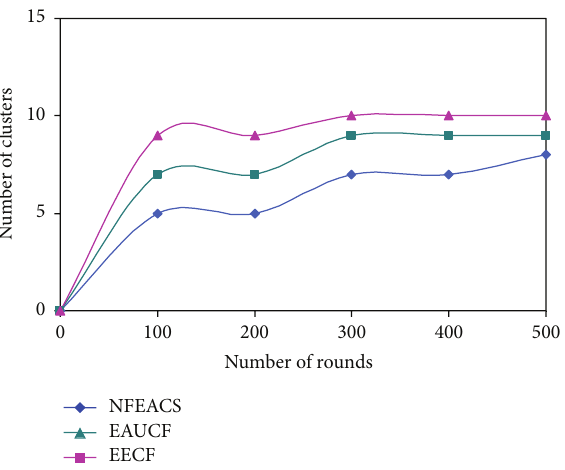
Figure 5: Number of clusters versus number of